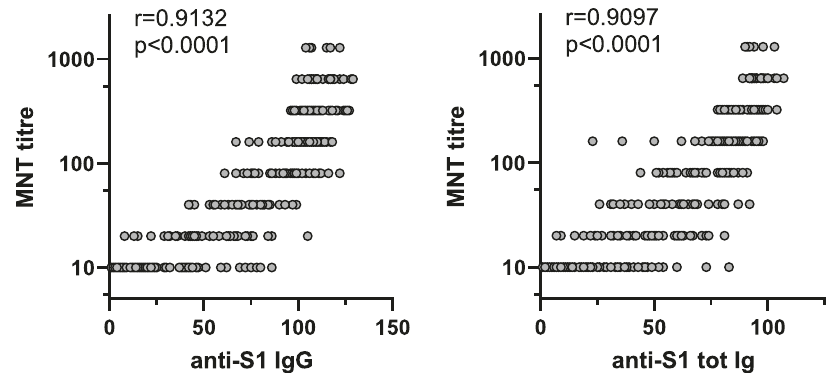
Fig. 6 Correlation of anti-S1 antibody levels with SARS-CoV-2 neutralization titres. Anti-S1 IgG and total Ig antibody levels were determined with EIA and neutralization titres of BNT162b2 vaccinated health care workers (initially seronegative, n = 169) against FIN-25 virus isolate were obtained with microneutralization test (MNT). All sequential serum samples (0d, 3wk, and 6wk) were included in the analysis. Spearman ’ s rank correlation coef fi cient ( r ) is